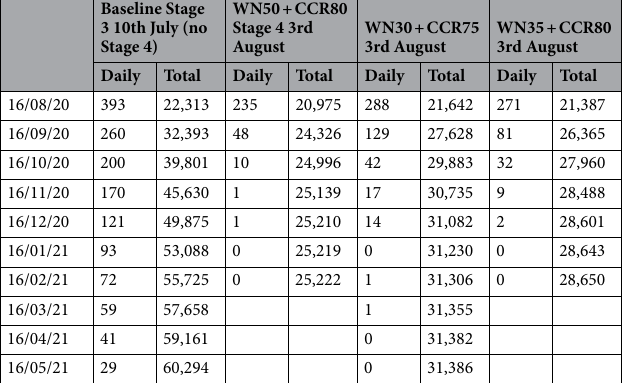
Table 2. Increased social distancing measures activated on 3rd August 2020, greater Melbourne (population 5 million). Daily cases mid-month and cumulative cases to 16th May 2021. All scenarios have Stage 3 measures activated on 10th July 2020, all schools are closed, and 70% case isolation for adults and 100% for children is